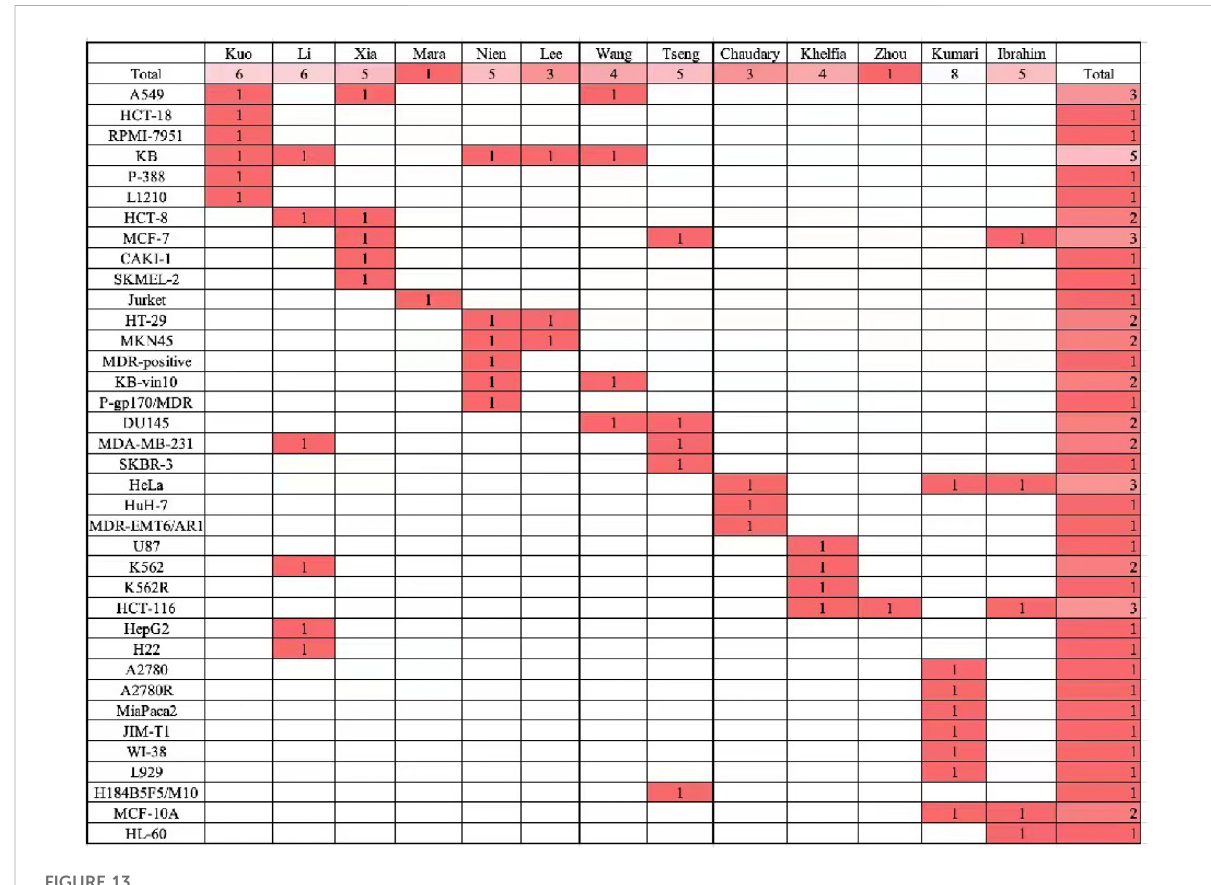
The researchers used all cell